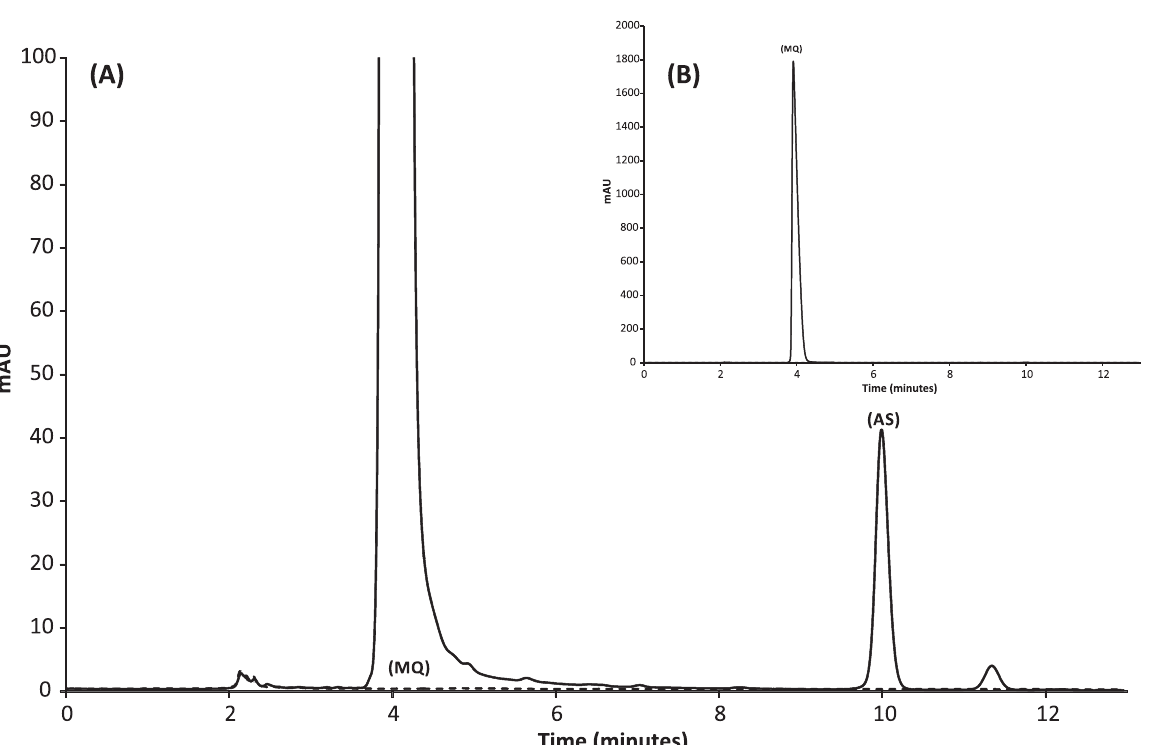
FIGURE 2 - (A) - Overlay of the chromatogram of the sample solution (full line, λ = 210 nm) and the chromatogram of the mixture of excipients (dotted line), optimized mobile phase, showing both mefloquine hydrochloride (MQ) and artesunate (AS) peaks. (B) - overlay of the chromatogram of the sample solution (full line, λ = 283 nm) and the chromatogram of the mixture of excipients (dotted line), using the optimized mobile phase, showing the mefloquine hydrochloride (MQ) TABLE II - Overview of the linearity data for AS and MQ Regression parameter Artesunate